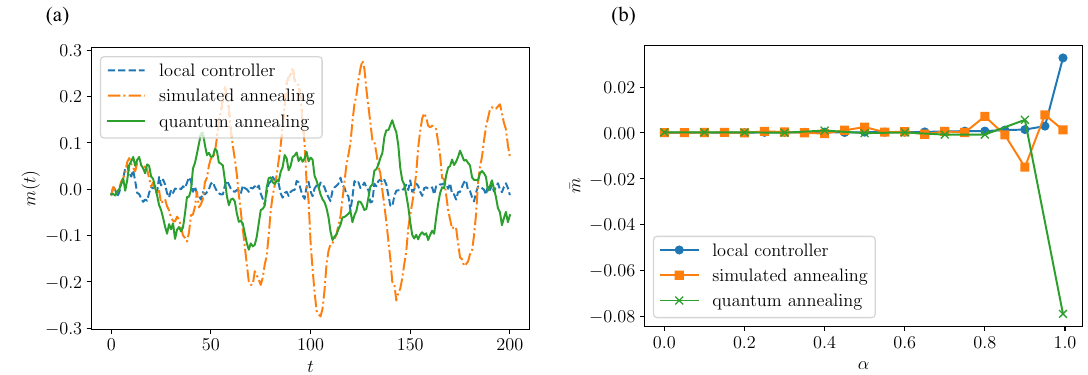
Figure 5. Magnetization of Eq. (18) under different control methods. ( a ) Time evolution of magnetization. Parameters α , η , and L are fixed as α = 0.8, η = 1.0 , and L = 50 , respectively. ( b ) Time average of magnetization as a function of α . Parameters η and L are the same as those in ( a